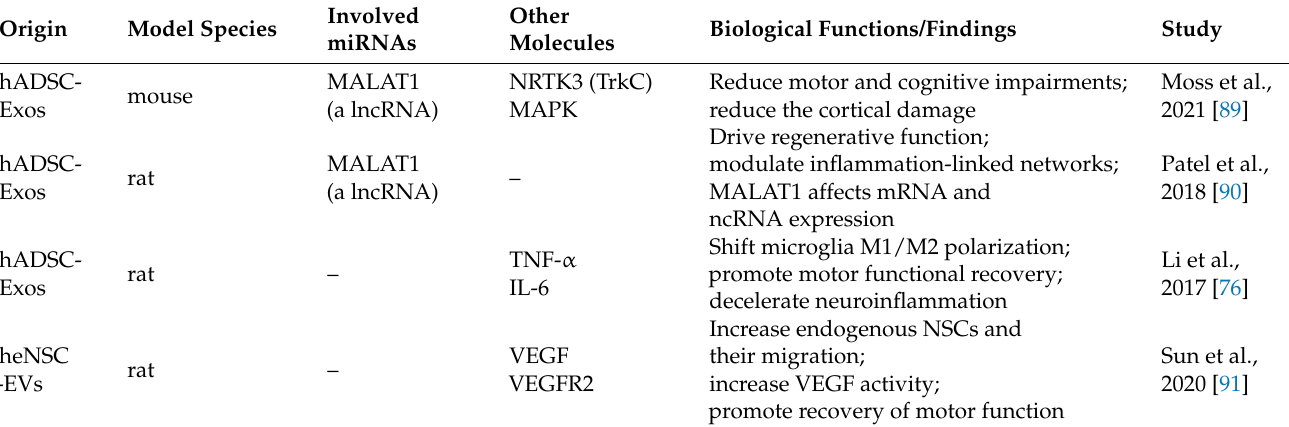
Table 5. Other stem cell-derived Exos/EVs and SC-Exos/EVs-miRNAs studies in